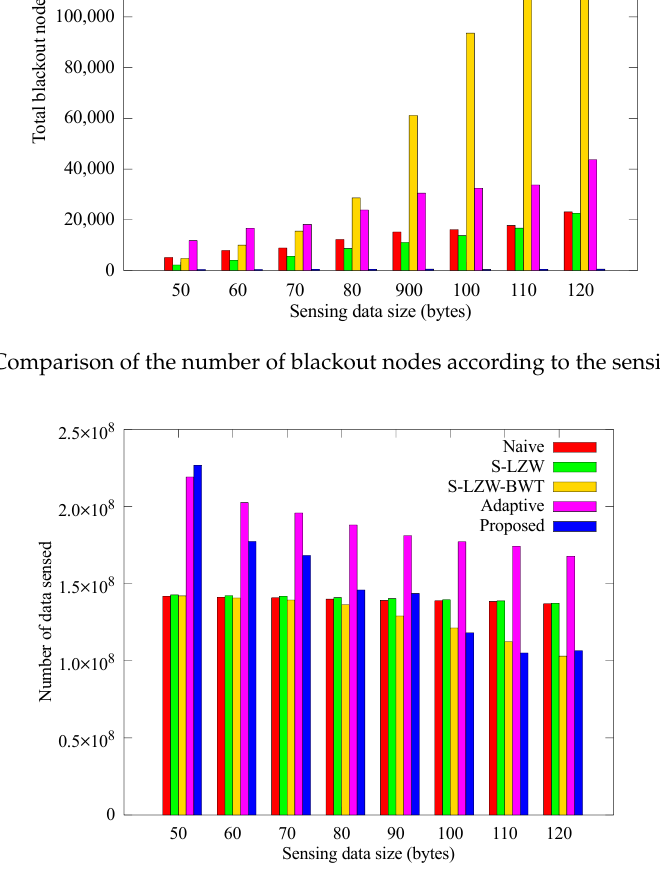
Figure 12. Comparison of the number of data sensed according to the sensing data size.